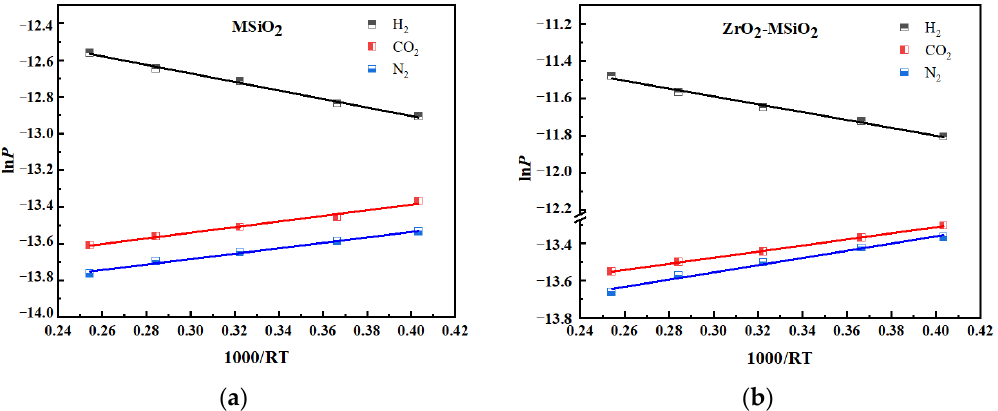
Figure 13. Arrhenius plots of different gases of ( a ) MSiO 2 and ( b ) ZrO 2 -MSiO 2 (n Zr = 0.15) membranes. Table 2. Arrhenius equation parameter values of MSiO 2 and ZrO 2 -MSiO 2 (n Zr = 0.15) membranes. Membrane